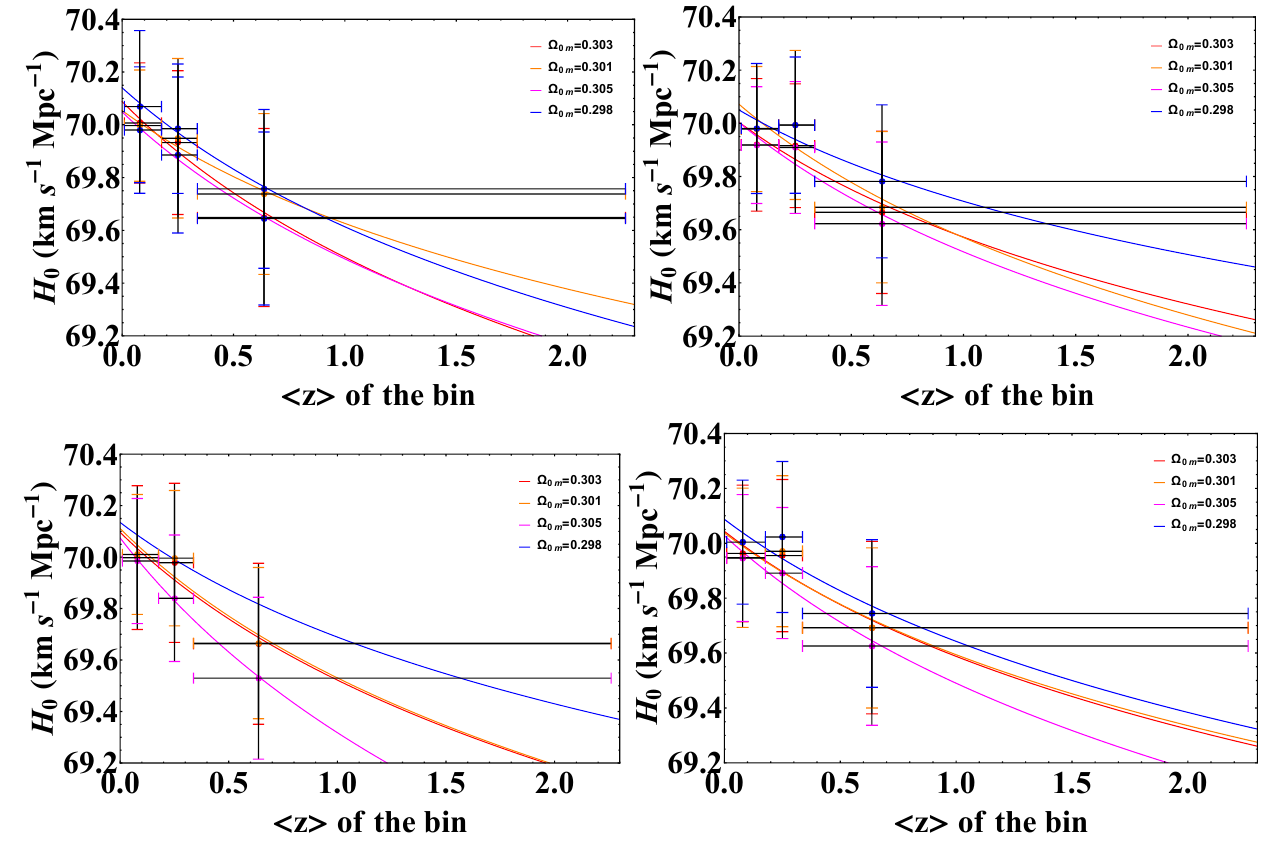
Figure 6. The Hubble constant versus redshift plots for the three bins of SNe Ia only, considering the Hu–Sawicki model. Upper left panel. The condition of F R 0 = − 10 − 7 is applied to the case of SNe only, with the different values of Ω 0 m = 0.301,0.303,0.305. Upper right panel. The same of the upper left, but with the contribution of BAOs. Lower left panel. The SNe only case with the F R 0 = − 10 − 4 condition, considering the different values of Ω 0 m = 0.301,0.303,0.305. Lower right panel. The same as the lower left, but with the contribution of BAOs. The orange color refers to Ω 0 m = 0.301, the red to Ω 0 m = 0.303, the magenta to Ω 0 m = 0.305, and the blue to Ω 0 m =